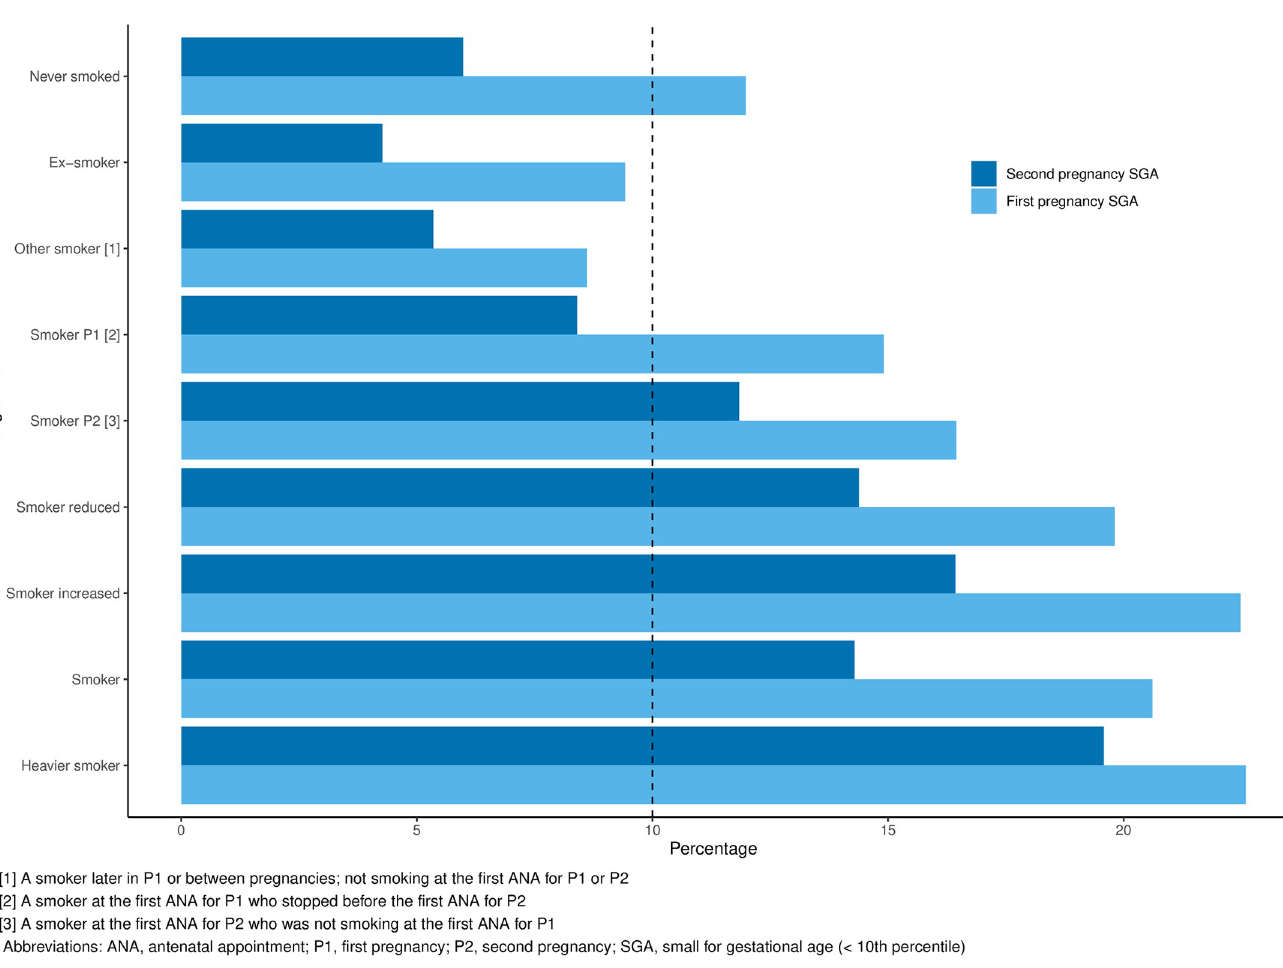
Fig 3. The percentages of small for gestational age births in the first and second pregnancies. Table 3 shows the univariate odds of small for gestational age birth in the second pregnancy by maternal characteristics recorded at the start of each pregnancy.